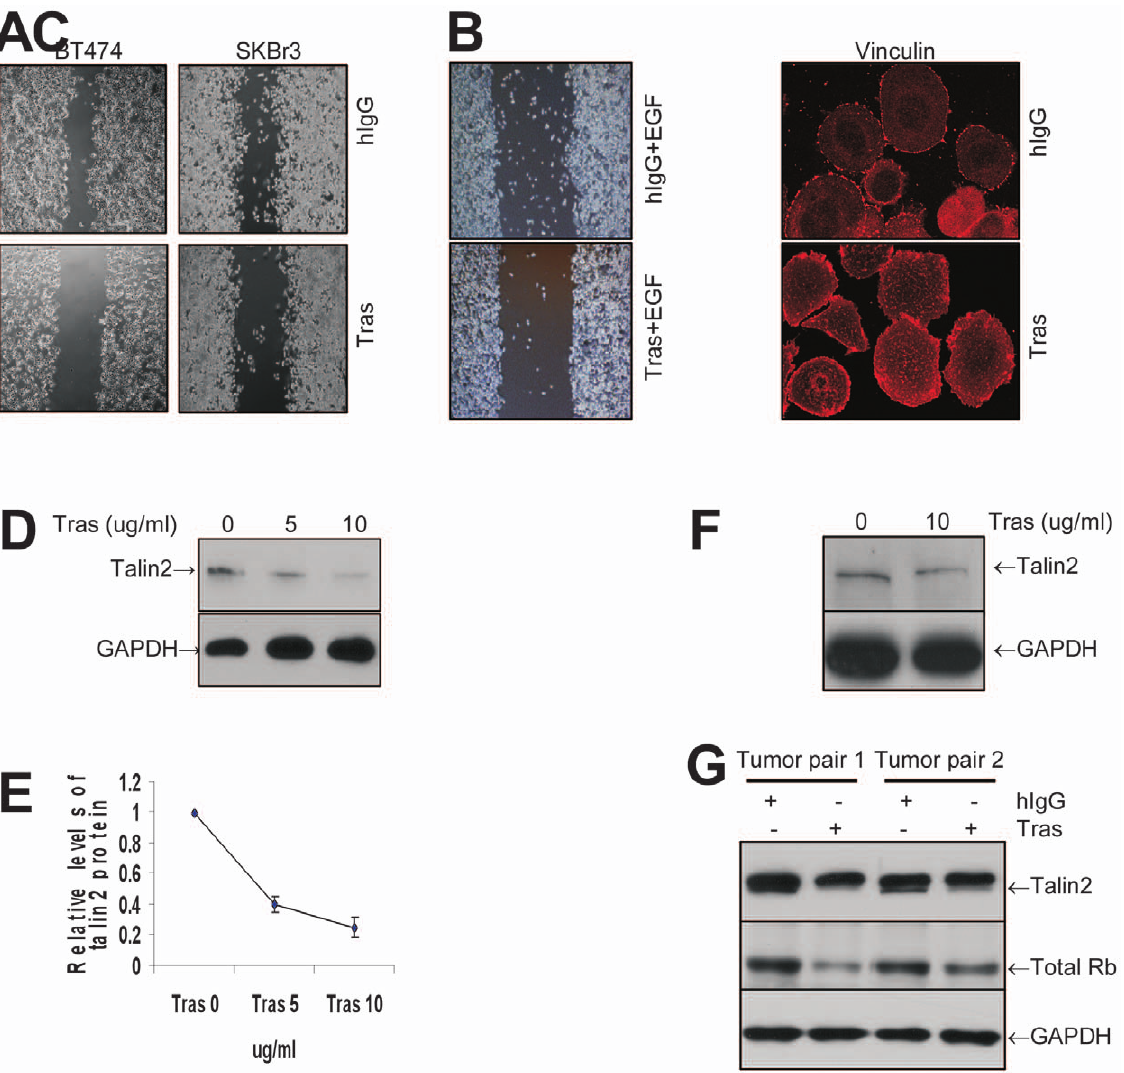
Figure 4. Trastuzumab treatment downregulates talin2 protein expression and inhibits breast cancer cell migration. ( A ) Effect of trastuzumab (Tras) on cell migration in a scratch assay. BT474 and SKBr3 cells were seeded in 6-well plates. After cells had grown to confluence, a scratch was made in the monolayer. Cells were treated with trastuzumab (Tras) or control hIgG (10 m g/ml) for 72 hrs. Images were recorded at 72 hrs at 40 6 enlargement. ( B ) Effect of trastuzumab on cell migration over a shorter interval (16 h) in a scratch assay. SKBr3 cells were seeded in 6-well culture plates and cultured overnight to achieve a cell density of full confluence. A scratch was made in the monolayer. Cells were then treated with trastuzumab (Tras) or control hIgG (10 m g/ml) plus epidermal growth factor (EGF, 20 ng/ml, sigma) for 16 hrs. Images were recorded at the end of 16 hrs of EGF stimulation at 40 6 enlargement. ( C ) Effect of trastuzumab (Tras) on cytoskeletal vinculin distribution after IF staining. SKBr3 cells were treated with trastuzumab (Tras) or control hIgG (10 m g/ml) for 48 hrs, and then subjected to IF staining as described in Methods. ( D ) Effect of trastuzumab on talin2 protein in BT474 cells. BT474 cells were treated in vitro with different concentrations of trastuzumab for 48 hrs. Total protein was prepared and subjected to Western blotting. ( E ) Quantitation of talin2 expression. The talin2 bands on immunoblots from three different experiments including the one shown in ( D ) were digitized, normalized to the levels of GAPDH, and expressed as mean levels (error bars correspond stand deviation). The talin2 expression at trastuzumab 0 concentration was set at 1. ( F ) Effect of trastuzumab on talin2 protein in SKBr3 cells. SKBr3 cells were treated with trastuzumab (Tras) or control hIgG (10 m g/ml) for 48 hrs. Total protein was prepared and subjected to Western blotting. ( G ) Effect of trastuzumab on talin2 protein in BT474 xenografts. BT474 xenografts in nude mice were treated with trastuzumab (Tras) or hIgG 1 mg/kg intraperitoneally twice a week and for 3 weeks. Total cell lysates were prepared and subjected to Western blotting. doi:10.1371/journal.pone.0041170.g004 treatment was no longer able to inhibit cell migration in the cancer cell migration by more than 55%. The ability of the miR- presence of miR-194 antagomir or inhibitor (Fig. 5C), indicating 194 antagomir to silence miR-194 was confirmed by QRT-PCR miR-194 induction was required for trastuzumab to slow cell as shown in Figure 5B. Similar results were observed in BT474 migration in breast cancer cells. cells, where inhibition of miR-194 by a miR-194 antagomir stimulated BT474 cell migration (Fig. 5C). Consistent with the results of in vitro scratch assay, trastuzumab treatment decreased the BT474 cell migration (Fig. 5C). However, trastuzumab